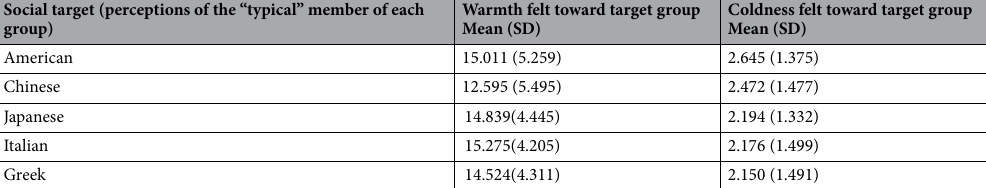
Table 1. Average warmth and coldness ratings for individuals from each country assessed. Participants reported the least warmth and greatest coldness toward Chinese nationals, of any group. Each field reports the mean and standard deviation of warmth and coldness ratings for each